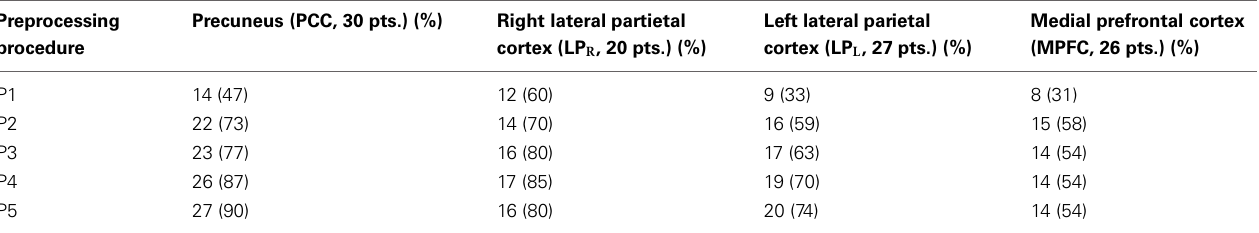
Independent component analysis